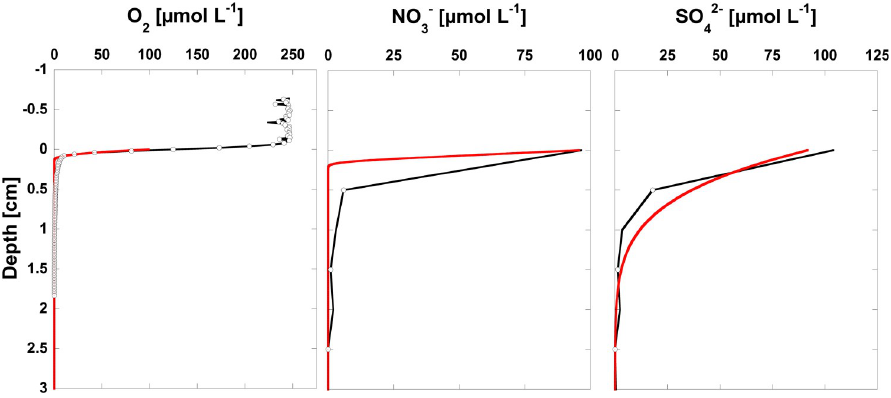
Fig 3. Modeled (red line) and measured (black line) porewater concentrations of the terminal electron acceptors O 2 , NO 3- and SO 42- . Direct O 2 measurements were taken only once during winter